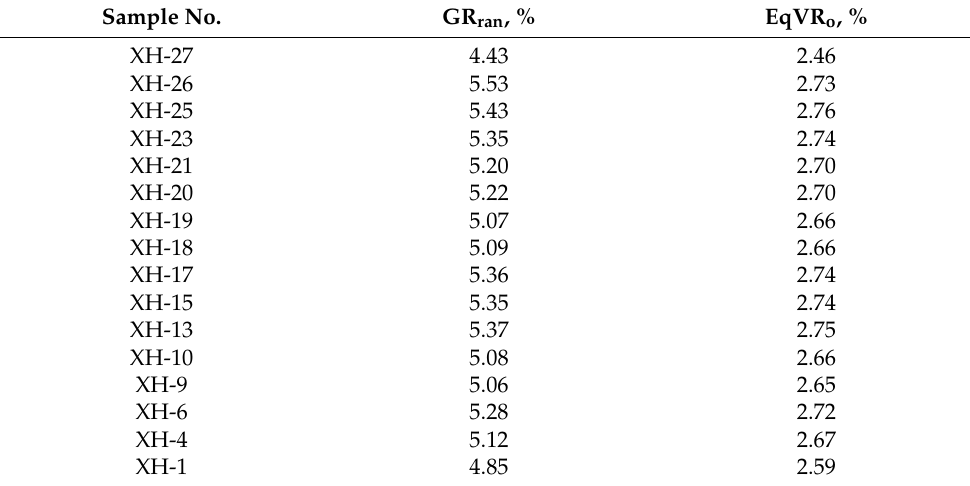
Table 2. Distribution characteristics of the reflectance of graptolites and equivalent vitrinite of the Longmaxi shales. Sample